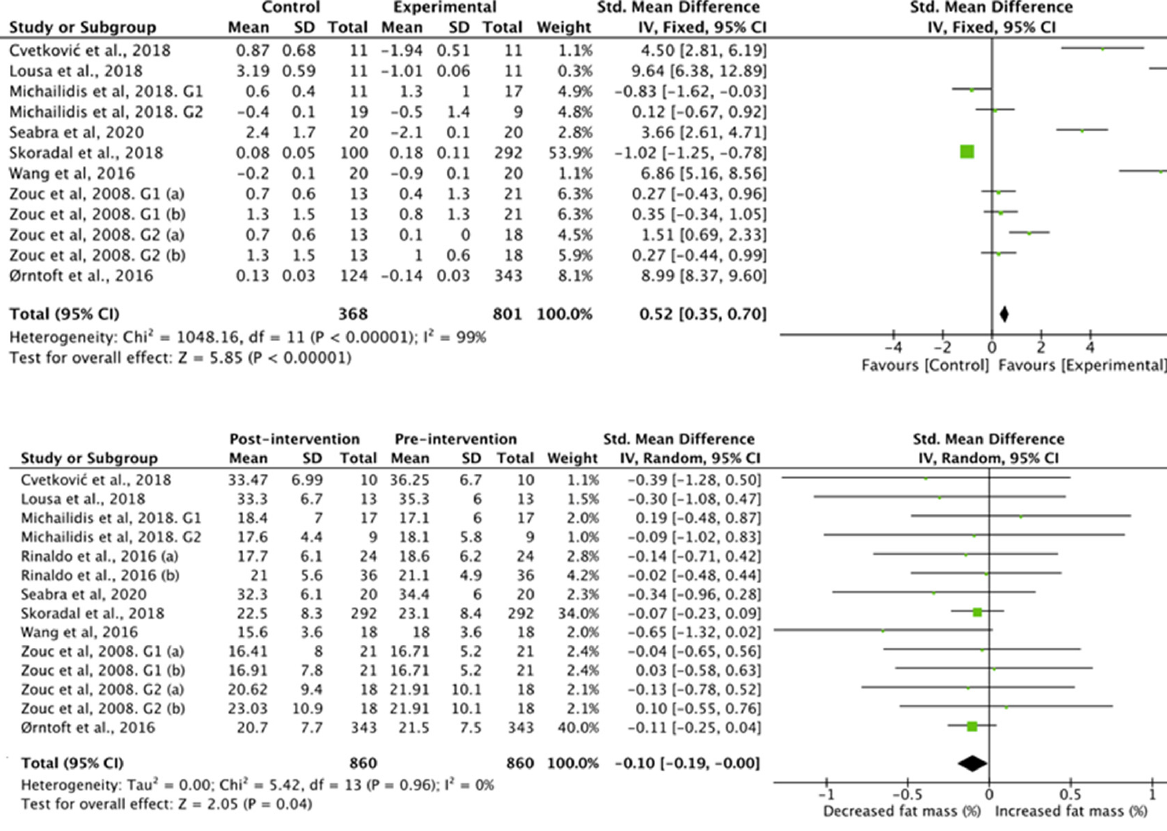
Figure 4. Results of random effects meta-analysis for the control group compared with the experimental group and results post and pre intervention, shown as mean difference and standardized mean difference with 95% CIs for fat mass